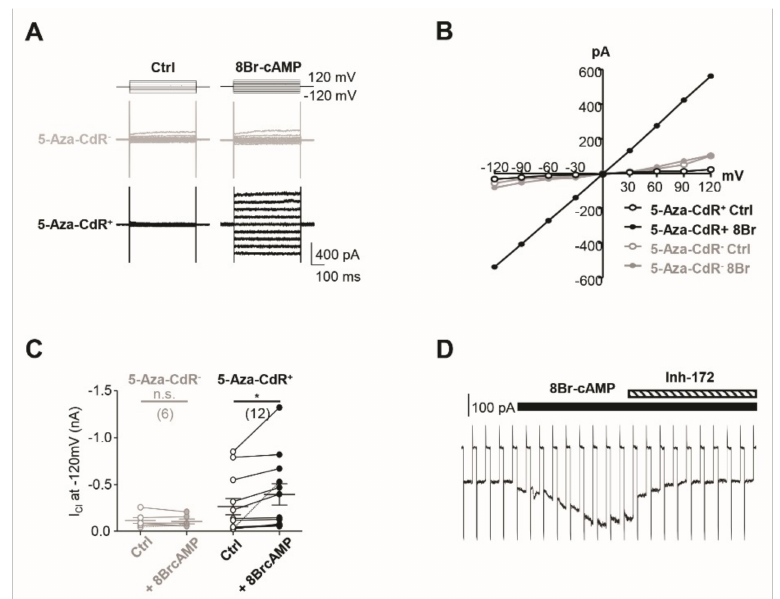
Figure 2. 8-Br-cAMP-sensitive chloride current is inhibited by CFTRinh-172 in 5-Aza-CDR-treated A253 cells. ( A ) A253 cells were stimulated with 200 µ M 8-Br-cAMP to measure the cAMP-sensitive chloride current. Black and gray traces represent chloride currents recorded in A253 cells with or without 5-Aza-CdR pretreatment, respectively. ( B ) Voltage–current relationship of chloride current before (ctrl, open circle) and after (8-Br-cAMP, closed circle) 8-Br-cAMP treatment of cells in panel ( A ). ( C ) Chloride current amplitude recorded at − 120 mV before (ctrl, open circle; n = 6; paired Student’s t -test, p = 0.3907; nonsignificant, n.s.) and after (8-Br-cAMP, closed circle; n = 12; paired Student’s t -test, p = 0.0262; * p < 0.05) 8-Br-cAMP treatment in A253 cells. Black and gray trials represent current amplitude from A253 cells with and without 5-Aza-CDR pretreatment, respectively. Trials in panel ( A ) are distinguished by dotted lines. ( D ) Inward chloride current was evoked by − 120 mV voltage steps from 0 mV holding potential for 500 ms at 5 s intervals ( n = 4). 8-Br-cAMP was associated with an increase of inward current, which was suppressed to basal levels by 10 µ M CFTR inh -172 (Inh-172)